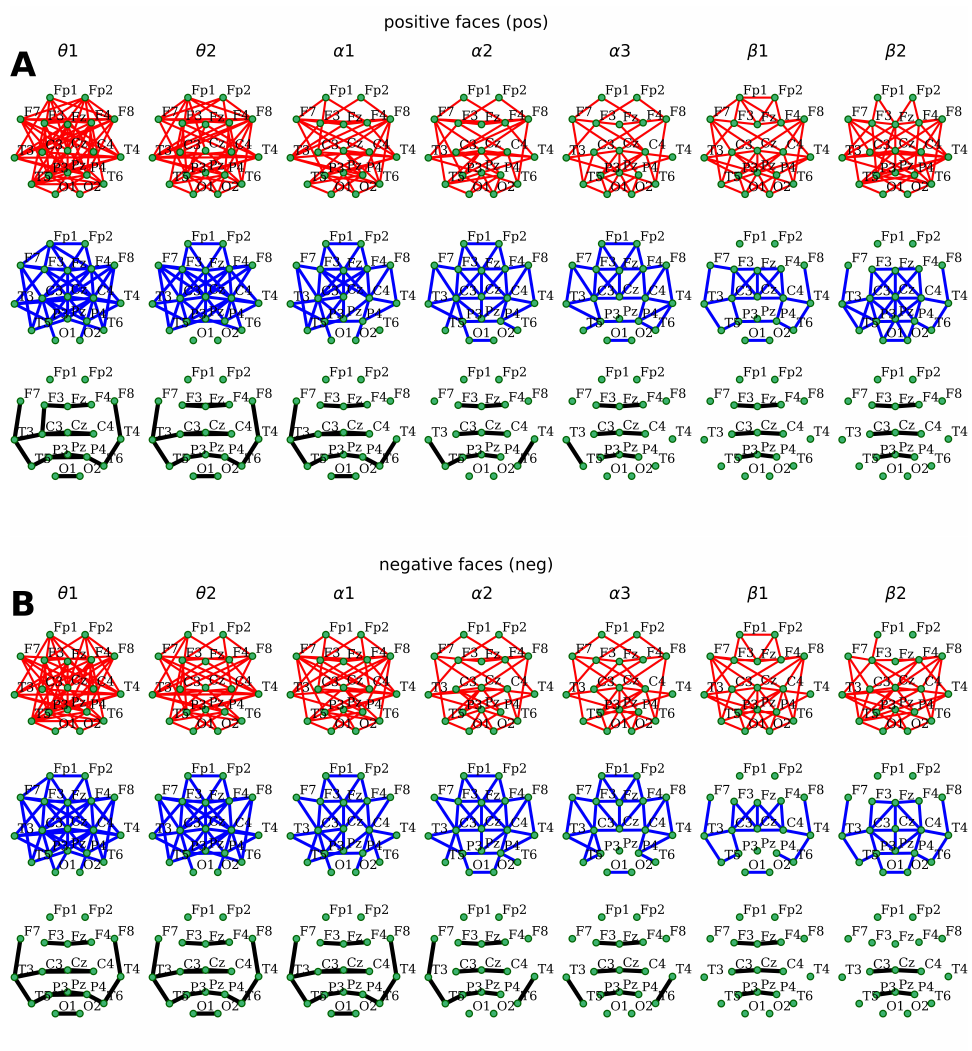
Figure 3. Topographical maps of coherent connections of different strength (red—0.3 < K < 0.5, blue—0.5 < K < 0.7, black—0.7 < K < 1.0) within EEG sub-bands during emotional facial perception: reaction to positive faces ( A ), reaction to negative faces ( B